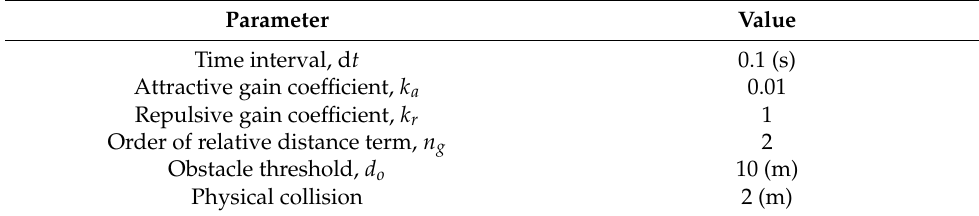
Table 2. Simulation parameters for the proposed CA approach.